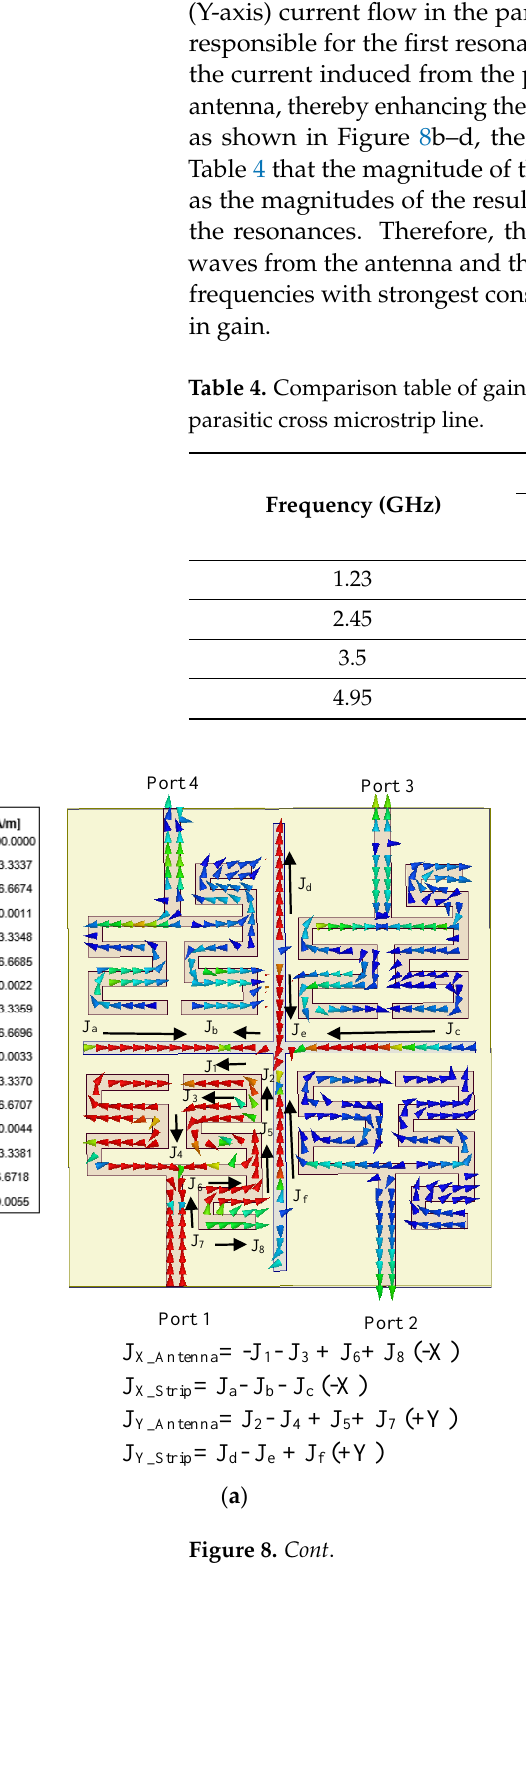
( d ) Figure 8. Current distribution of MIMO antenna with cross parasitic microstrip line structure at ( a ) 1st resonance, ( b ) 2nd resonance, ( c ) 3rd resonance and ( d ) 4th resonance.